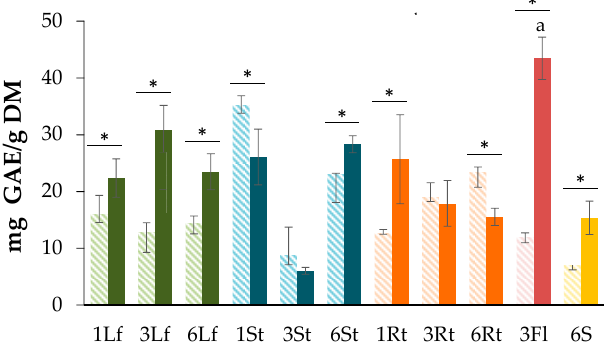
Figure 2. Total flavonoid content (TFC) of C. quinoa processed by air-drying (dash bars) and freeze-drying (dark bars) at different times after seeding (1, 3, 6 months) of different plant parts (leaves (Lf), stems (St), roots (Rt), seeds (S), and flowers (Fl)). Each bar represents the mean ± standard deviation ( n = 3). Significant differences were found between plant parts ( p = 0.00507 < 0.01), but no differences existed for harvesting times and processing method ( p = 0.85371 > 0.05). * p < 0.05 when compared between drying methods.